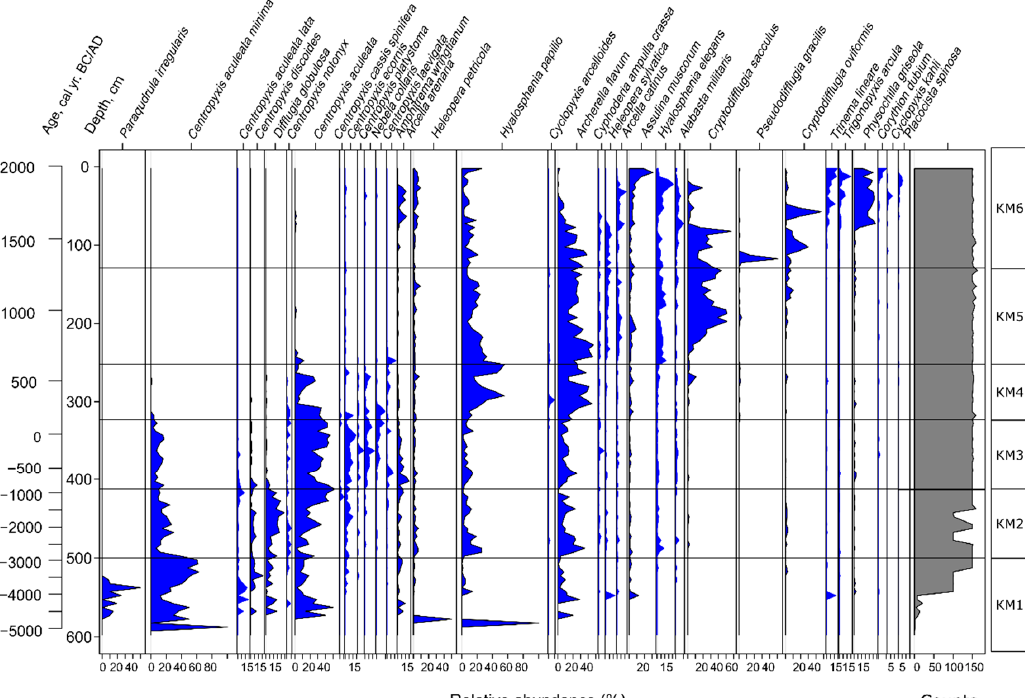
Figure 8. Composition of testate amoeba assemblages in the deposits of the Krivetskiy Mokh mire (only species observed in at least five samples with a relative abundance of 5% or more are shown). Blue color—relative abundance of taxa, grey color—total counts. KM1–KM6—the zones defined based on the main developmental stages of the mire.